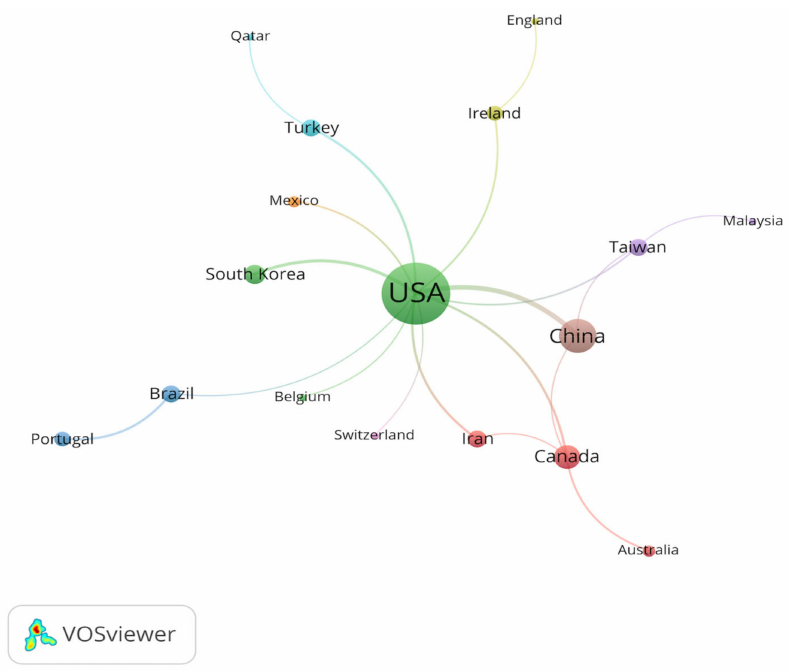
Figure 5. Cooperation between contributing countries/regions regarding PA research on ASD. Table 4. Top 10 countries/regions and institutions on PA research of